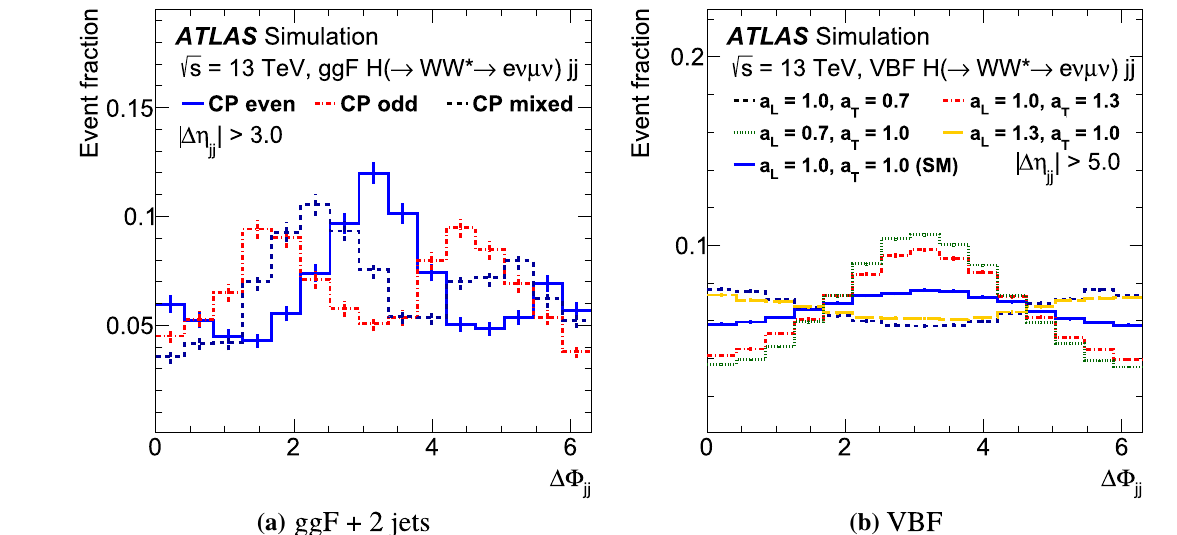
Fig. 2 Distributions of the signed (cid:10)(cid:11) jj observable shown for a CP- even, CP-odd and CP-mixed benchmark models of the ggF + 2 jets production mode, and b various configurations of the a L and a T param-